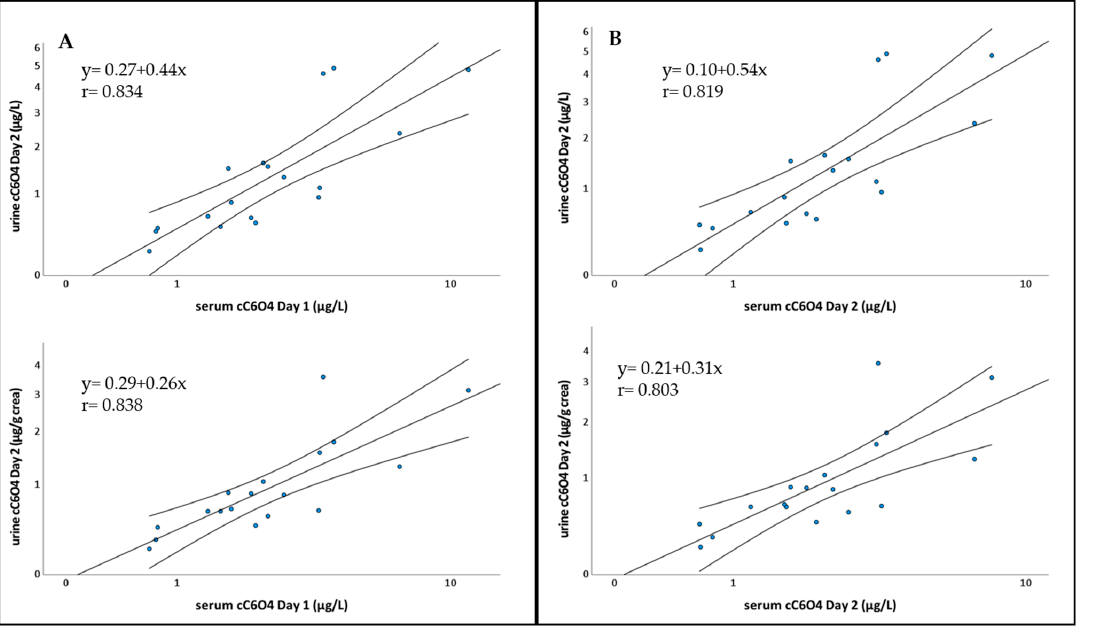
Figure 2 . Correlation between the concentration of cC 6 O 4 in day 2 urine not adjusted for creati-